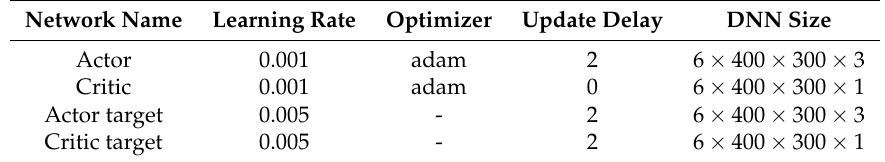
Table 2. Tuning parameters for the designed TD3 with HER.